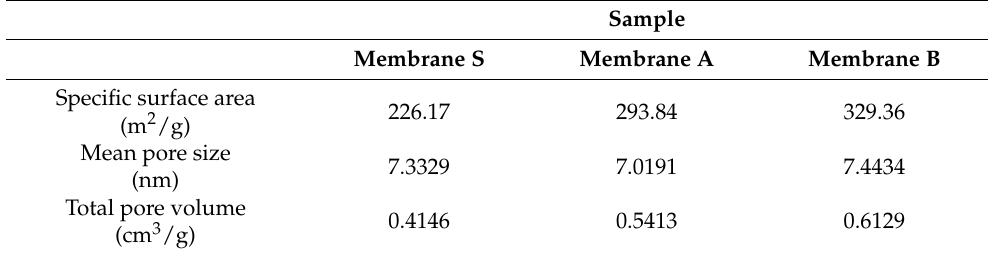
Table 2. Pore characteristics determined by nitrogen adsorption experiment for γ -Al 2 O 3 membranes.